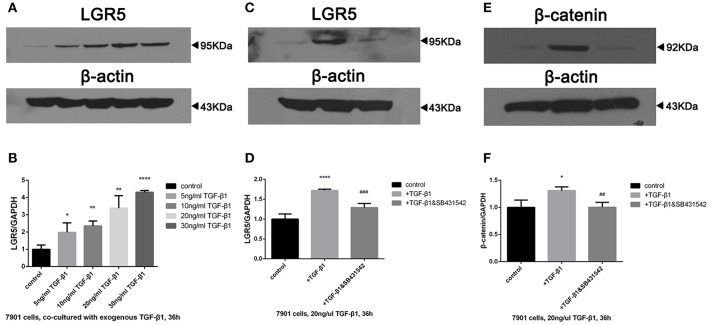
TGF-β1 regulated the overexpression of Lgr5 and β-catenin in GC cells via TGF-β1 signaling pathway. (A,B) Lgr5 expression in GC cells exposed to 0, 5, 10, 20, and 30 ng/ml TGF-beta1 for 36 h determined by Western blot (A) and Q-PCR (B). (C–F) GC cells were treated with 20 ng/ml TGF-beta1 in the presence of 0, 10 uM SB431542 for 36 h, Lgr5 expression (C,D) and beta-catenin (E,F) in GC cells was detected by Western blot (C,E) and Q-PCR (D,F). The mRNA level was normalized to that of GAPDH in the same cell extracts. *P < 0.05, **P < 0.01, ****P < 0.0001 between GC cells treated with different concentration of TGF-beta1 and control group. ##P < 0.01, ###P < 0.001 between TGF-beta1-treated GC cells with or without 10uM SB435421. GAPDH, glyceraldehyde 3-phosphate dehydrogenase; GC, gastric cancer; Lrg5, leucine-rich repeat containing G protein-coupled receptor 5; MACS, magnetic-activated cell sorting; qRT-PCR, quantitative revere transcription polymerase chain reaction; TGF-β1, transforming growth factor beta 1.